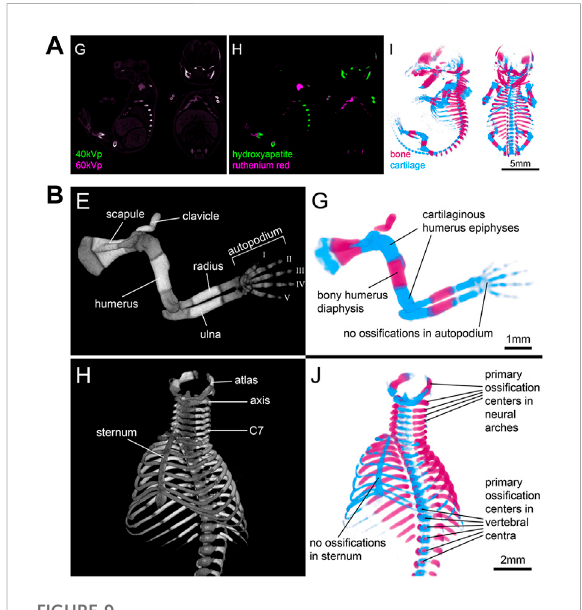
FIGURE 9 Microscopic dual energy CT (microDECT) for imaging skeletal development. (A) MicroDECT for imaging cartilage and bone in ruthenium red stained E16.5 mouse embryos. The embryo isscannedusingtwodifferentX-rayspectra(40 kVp,60 kVp), which allows separating of hydroxyapatite and ruthenium attenuation using material decomposition. Material fractions can be visualized using volume rendering and false colours mimicking the colour of Alizarin red/Alcian blue stained specimens (Figures 3G – I from Gabner et al., 2020, Development 147 (11)). (B) Examples of conventional greyscale microCT visualisation (left) andmicroDECTvisualisation(right)ofthedevelopingforelimband ribcage in a wild type E16.5 mouse embryo [Figures 4E,G,H,J from Gabner et al., 2020, Development 147 (11)]. All imagesreprinted by permission from the Company of